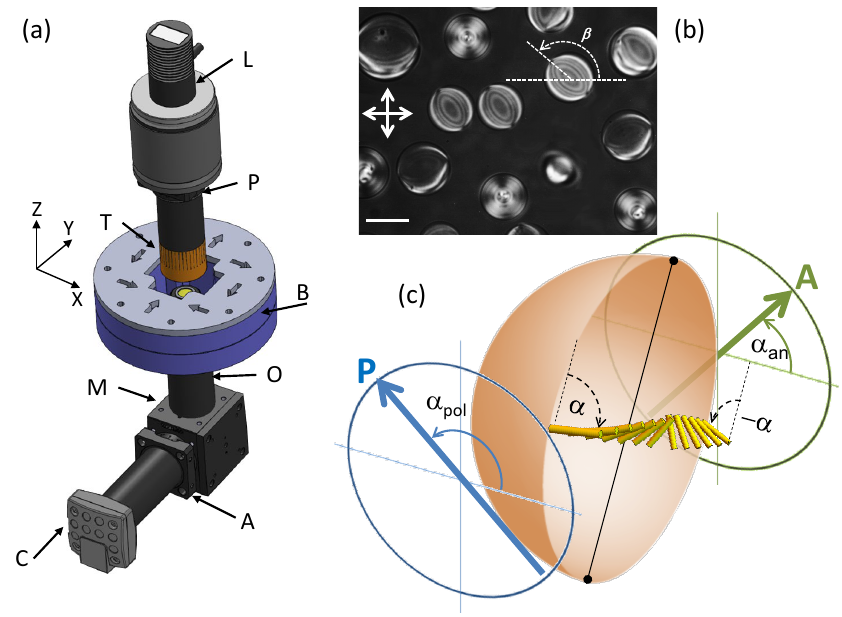
Figure 1. ( a ) Experimental setup. A homemade polarizing microscope is fitted with a permanent magnet array that imposes a magnetic field in the XY plane. ( b ) Typical ensemble of Sunset Yellow (SSY) nematic gems in coexistence with isotropic liquid as seen between crossed polarizers. The orientation of the symmetry axis of a gem with respect to the horizontal defines the angle β . ( c ) Geometrical parameters used in the analysis of the director field profile through the center of the gems. Scale bar is 100 µ